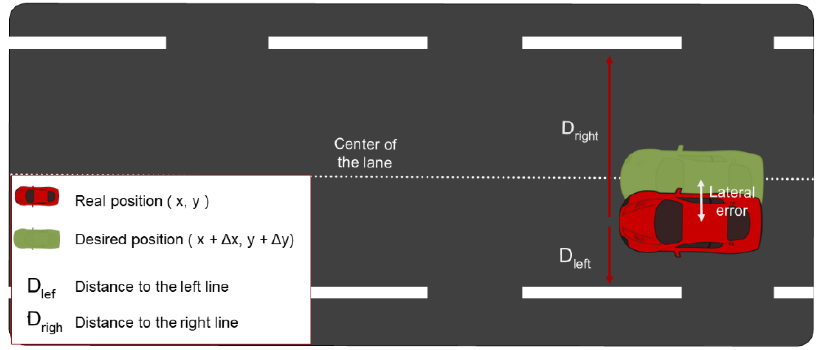
Figure 2. System overview for lane-centering mechanism depicting the left and right lateral error values (D left , D right ) obtained by the computer vision system.